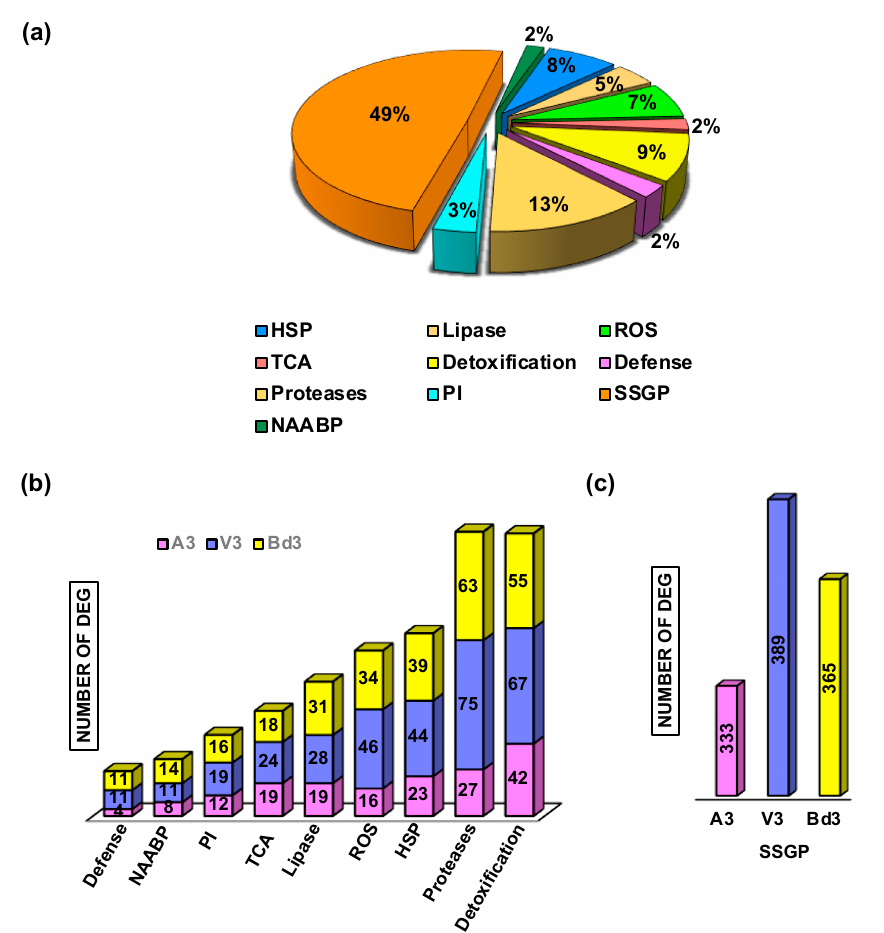
Figure 5. Differentially expressed genes (DEG) representing diverse functional categories. ( a ) Pie chart representing the fractions of functional categories representing the transcriptome of the avir- ulent (A3), virulent (V3), and Bd3 larvae. The categories are: Heat Shock Proteins (HSP), Lipase, Reactive Oxygen Species (ROS), Tricarboxylic Acid (TCA) pathway, Detoxification, Defense, Prote- ases, Protease Inhibitors (PI), Secreted Salivary Gland Proteins (SSGP), and Nonessential Amino Acid Biosynthetic Pathway (NAABP). ( b ) The number of DEG in A3 (pink), V3 (purple), and Bd3 (yellow) larval transcriptomes for genes representing different functional categories. ( c ) The number of DEG in A3 (pink), V3 (purple), and Bd3 (yellow) larval transcriptomes encoding SSGP.